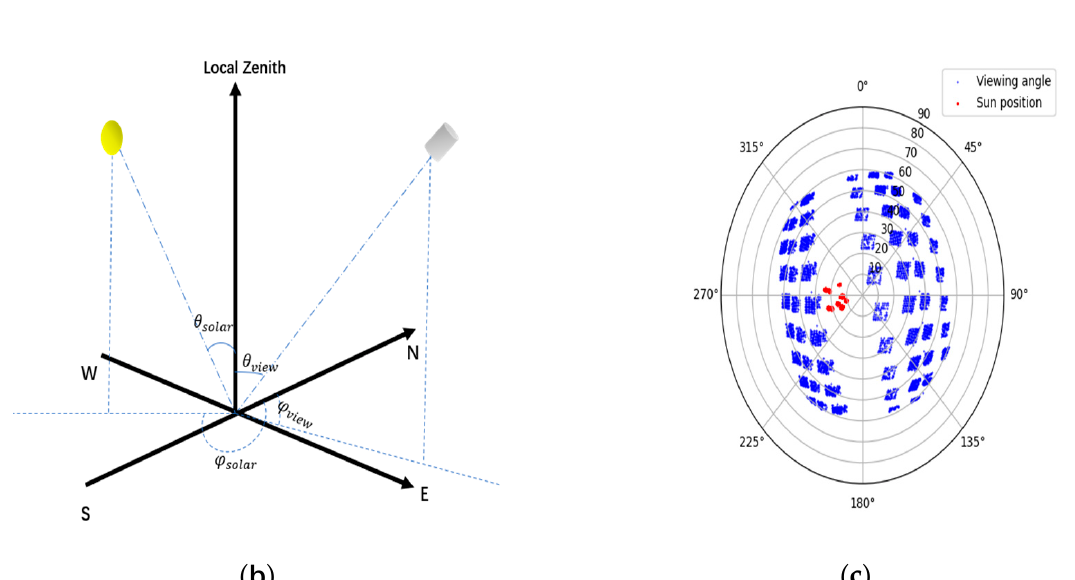
Figure 3. The reflectance measured by the DPC in flight and the geometry of the level-1B product: ( a ) true color fusion image of the reflectance measured by the DPC on June 10, 2018. ( b ) A geometrical illustration of the DPC. ( c ) The geometry of calibration samples after data selection.